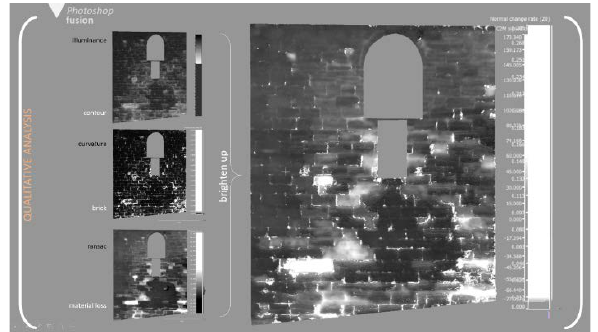
Figure 15. Qualitative overlay of maps.